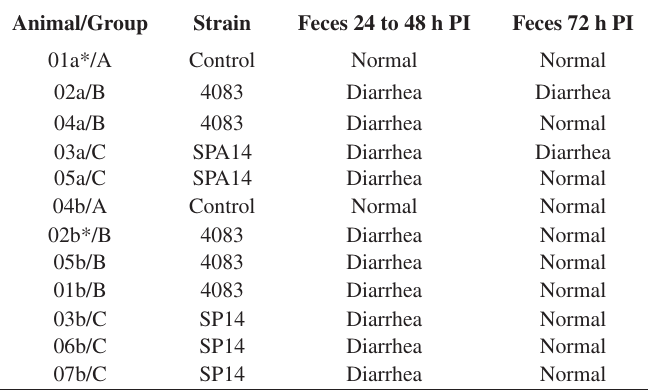
TABLE 2 - Identification of dogs and strains inoculated into each experimental group, showing persistence or not of diarrhea at 72 h post-infection (PI)